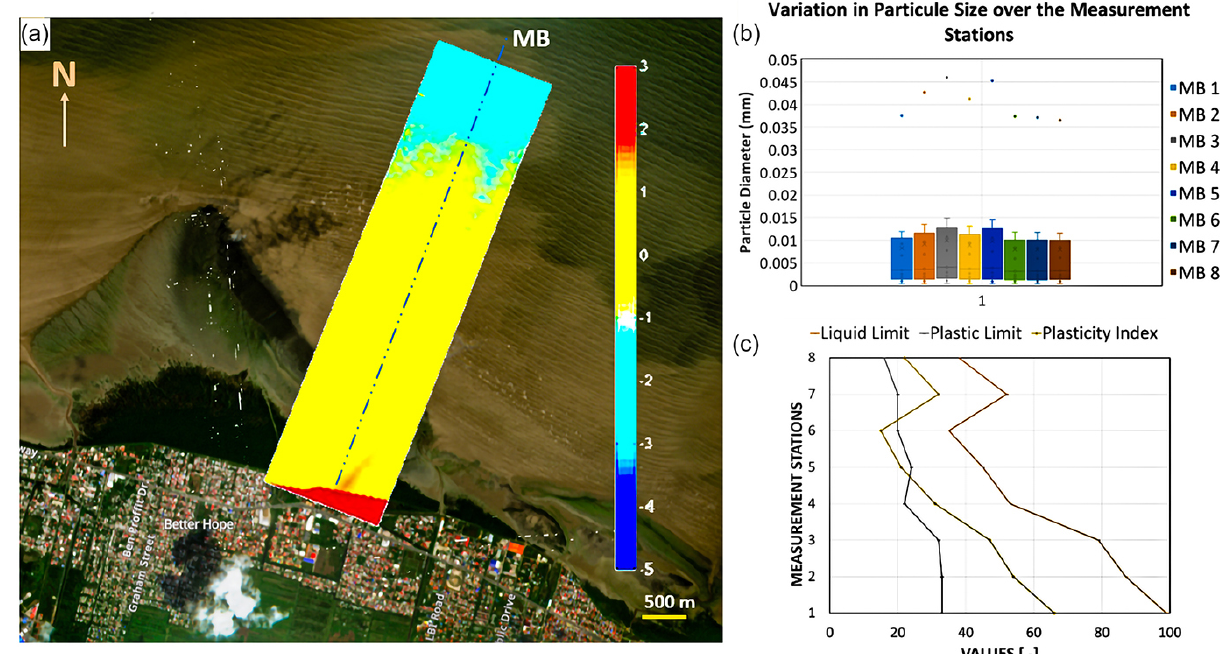
Figure 7. (a) Topographic survey of the data collection site (1000 × 3500m). (b) Variation in the sediment particle diameters at each station point attained from the hydrometer tests. (c) Comparison of the Atterberg limits across transect